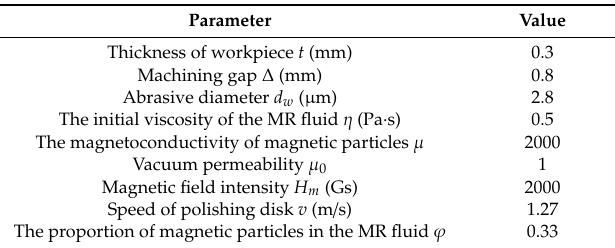
Table 3. Calculating